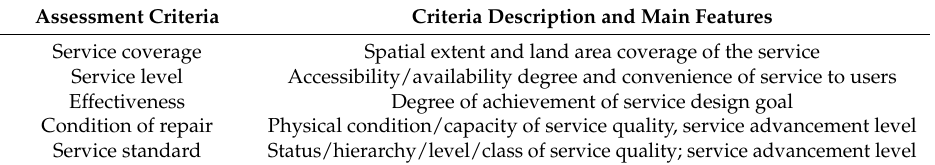
Table 1. Criteria for assessing man-made infrastructure drainage service. Modified from [41].